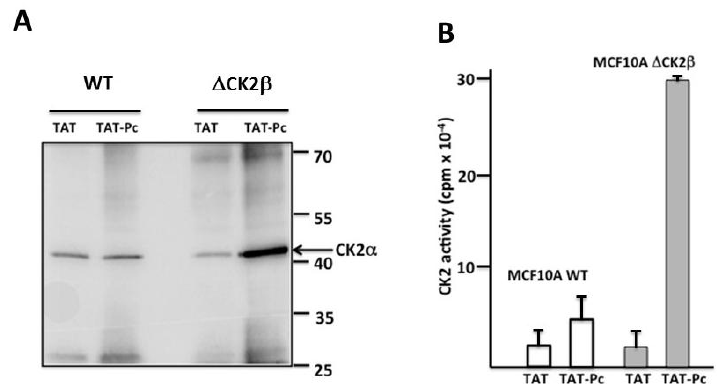
Figure 6. Physical binding of CK2α to TAT-Pc 13 in cell extracts. WT or CK2β-depleted MCF-10A cell lysates were incubated with 50 µM TAT or TAT-Pc 13 for 30 min at room temperature and immunoprecipitated with a TAT antibody. CK2α protein and CK2 activity were evaluated by Western blot ( A ) and CK2 kinase assay ( B ), respectively. Representative data for CK2 activity shown from two independent experiments. Results are presented as mean ± s.d. of triplicates.